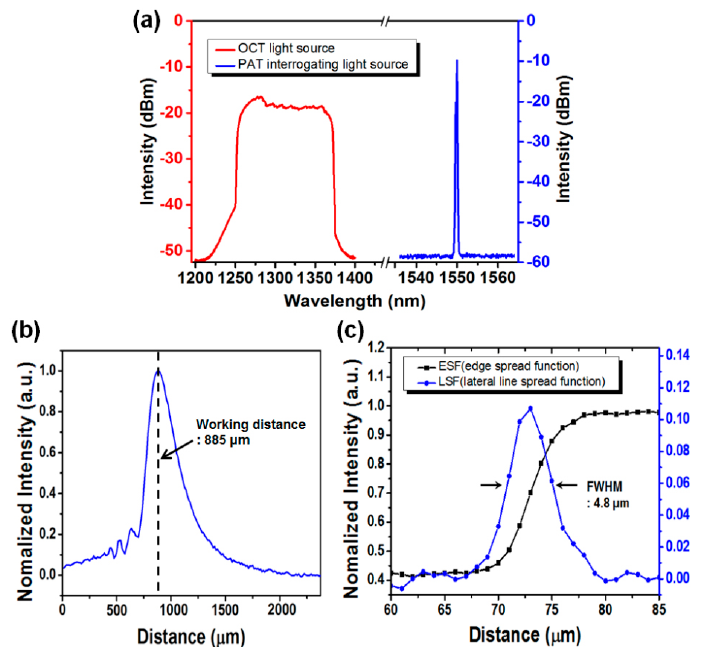
Figure 3. ( a ) The wavelength spectrum of the combined beam of OCT and PAT after passing wavelength division multiplexer (WDM). ( b ) The recoupling optical power of the light beam back reflected from a mirror moving away from the lens tip, plotted in terms of the mirror distance from the tip. ( c ) Edge spread function (ESF) obtained from a knife-edge mirror (square-symbol black line) and line spread function (LSF) obtained by taking the derivative of ESF (round-symbol blue line).